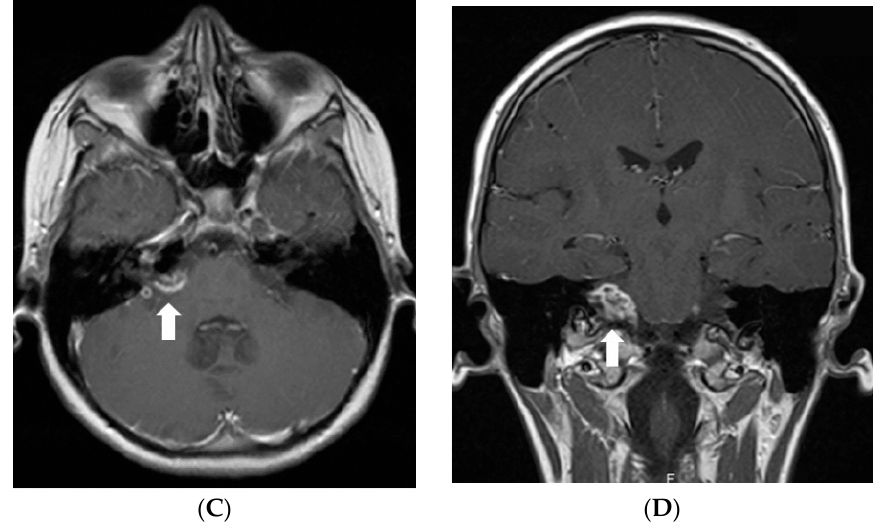
Figure 1. Initial MRI of the brain at our clinic (July 2011): ( A ) Axial T2W/FLAIR and ( B ) coronal T2W images demonstrate a hyperintense mass in the right cerebellopontine angle cistern and internal auditory canal. ( C ) Axial and ( D ) coronal T1W postcontrast images show heterogenous enhancement in the referred area.